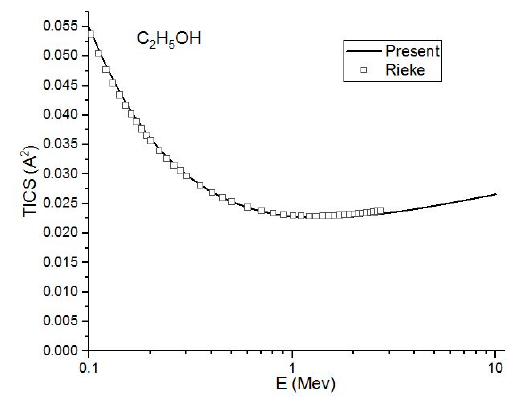
Figure 5. In this figure, we compare the present (Ave.) ( - ) theoretical total ionization cross sections in Å (cid:2870) to the experimental ( ) results of Rieke and Prepejchal [15] for C 2 H 5 OH at a high energy range.